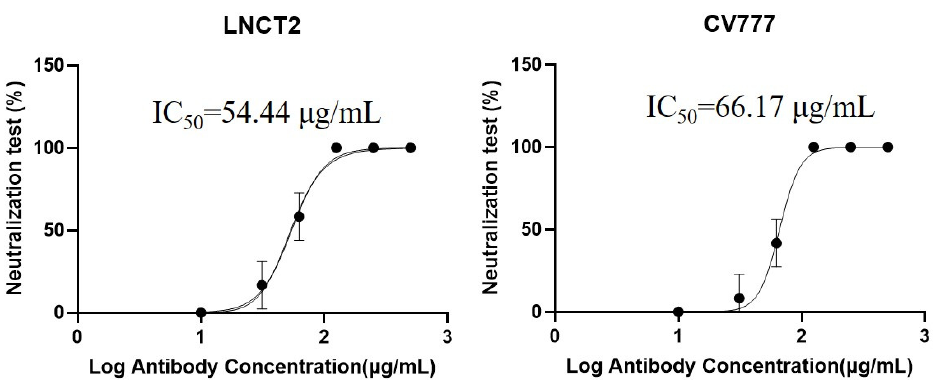
Figure 2. Neutralization of distinct PEDV strains by mAb 5F7. PEDV strains LNCT2 and CV777 were used to test the neutralization features of mAb 5F7. The IC 50 of the mAb 5F7 in neutralizing strains LNCT2 and CV777 were 54.44 µ g/mL and 66.17 µ g/mL, respectively. The neutralization tests were repeated three times. The five points of antibody concentration from low to high are 10 µ g/mL, 31.25 µ g/mL, 62.5 µ g/mL 125 µ g/mL, 250 µ g/mL, 500 µ g/mL. The figures were generated with GraphPad Prism version 9.0 (GraphPad Software, La Jolla, CA,